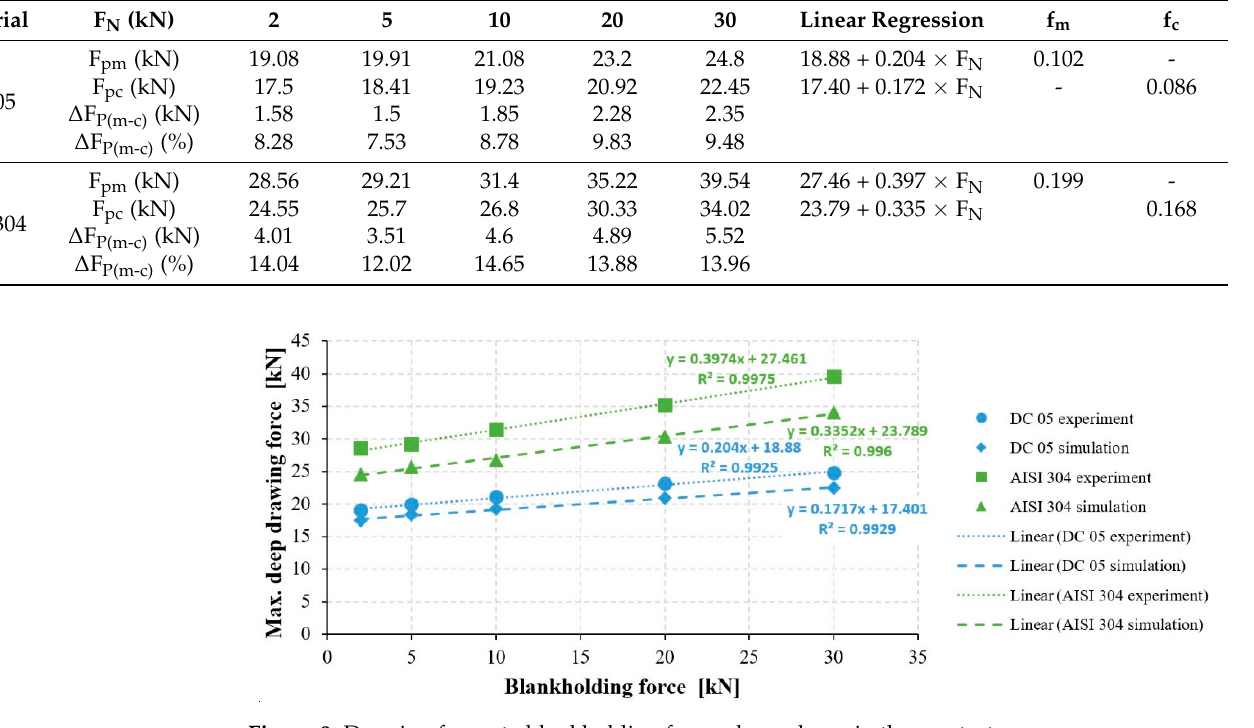
Figure 8. Drawing forces to blankholding forces dependence in the cup test. Comparing friction coefficients f 1,2 determined by the friction simulator (Table 4) and the friction coefficient values f m determined by the cup test (Table 5) resulted in good conformity for material DC 05 with a difference ∆ f = 0.008. However, there is a higher difference ∆ f = 0.03 for material AISI 304, even though it is within the error of measurement. When comparing the results of the cup test and numerical simulations of the cup test, there is good conformity for material DC 05 with difference ∆ f = 0.016, but the difference for material AISI 304 is higher ∆ f = 0.031 (Table 6). Considering it is the austenitic